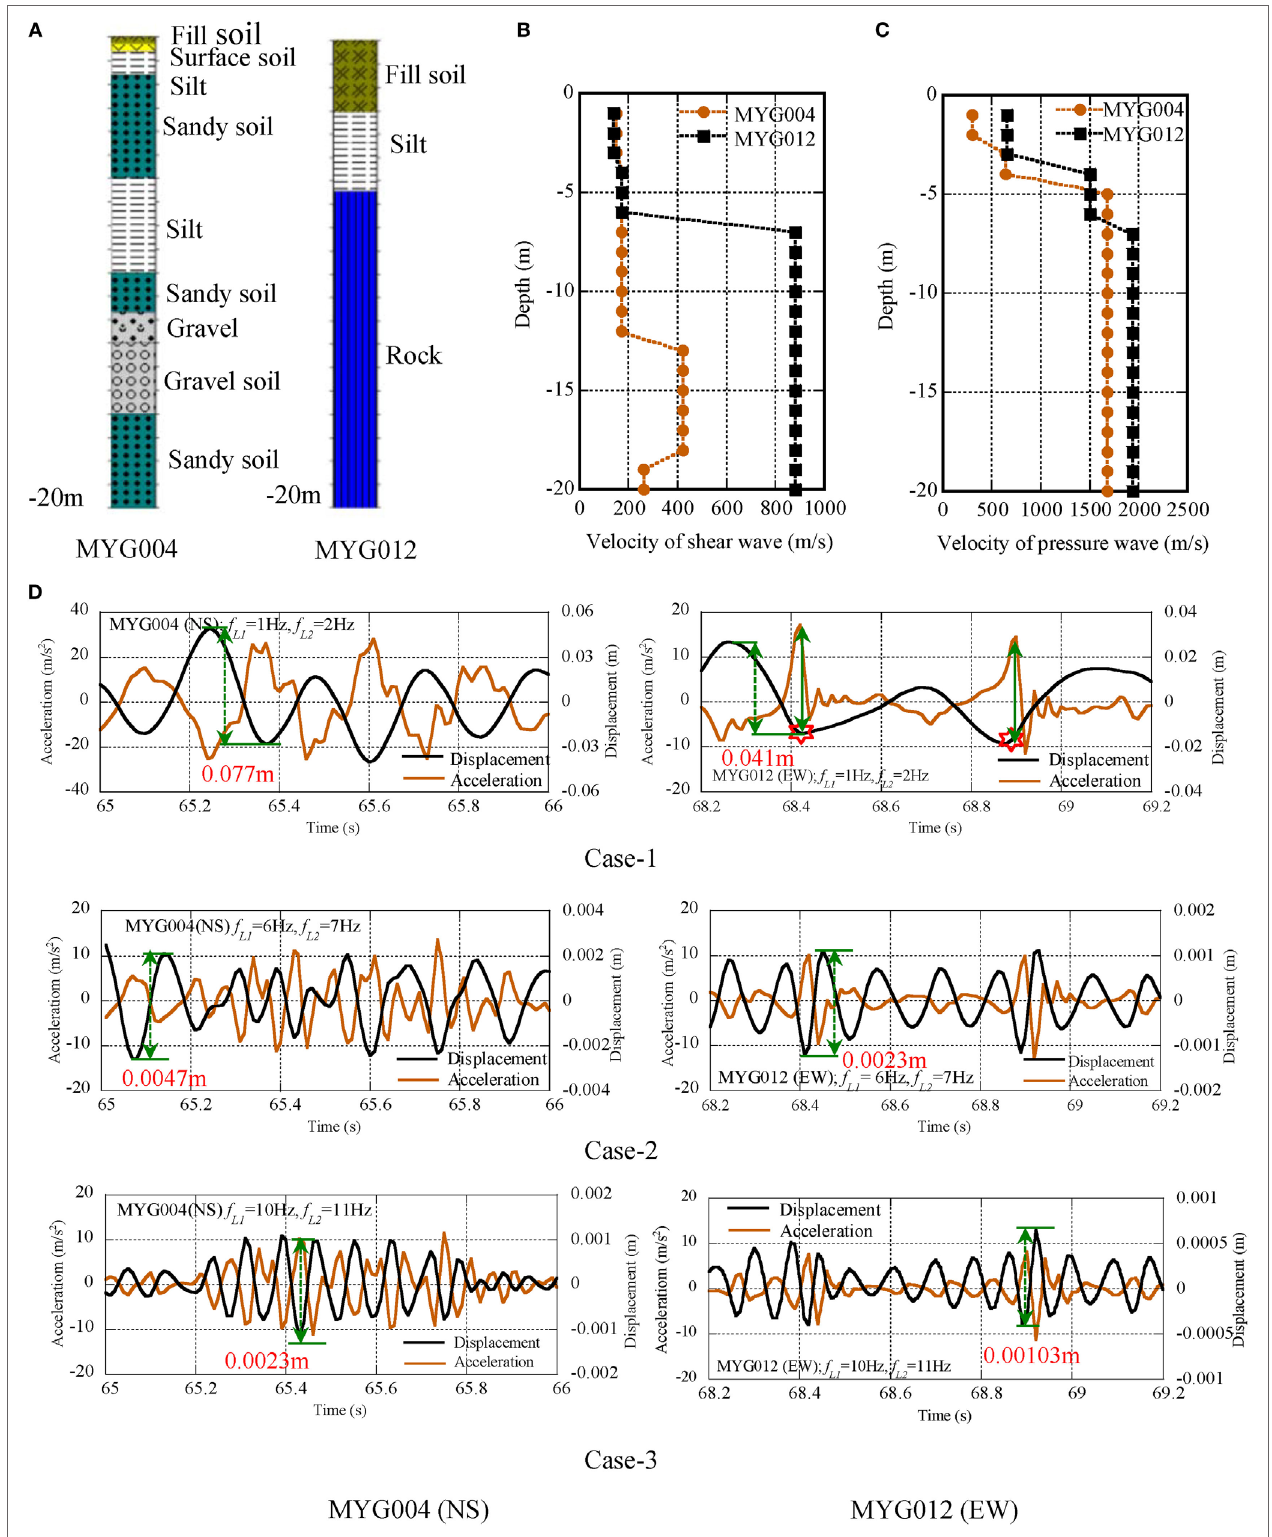
FigUre 4 | Acceleration and displacement profiles of MYG004 (NS) and MYG012 (EW), (a) surface soil condition, (b) V S , (c) V P , (D) comparison of acceleration and displacement